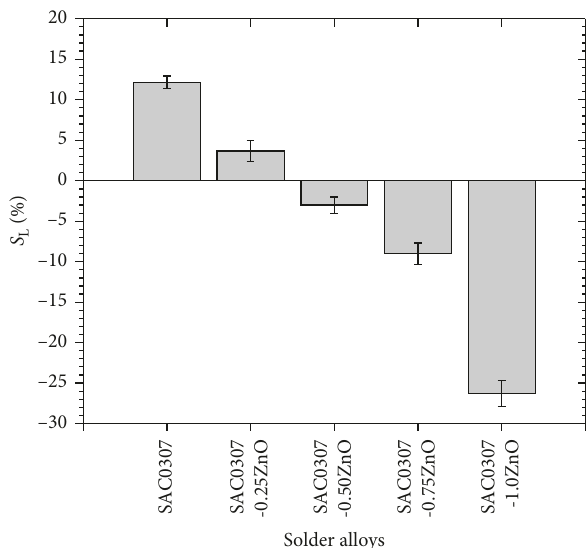
Figure 6: The slumping of the SAC0307-xZnO solders on the copper substrate at room